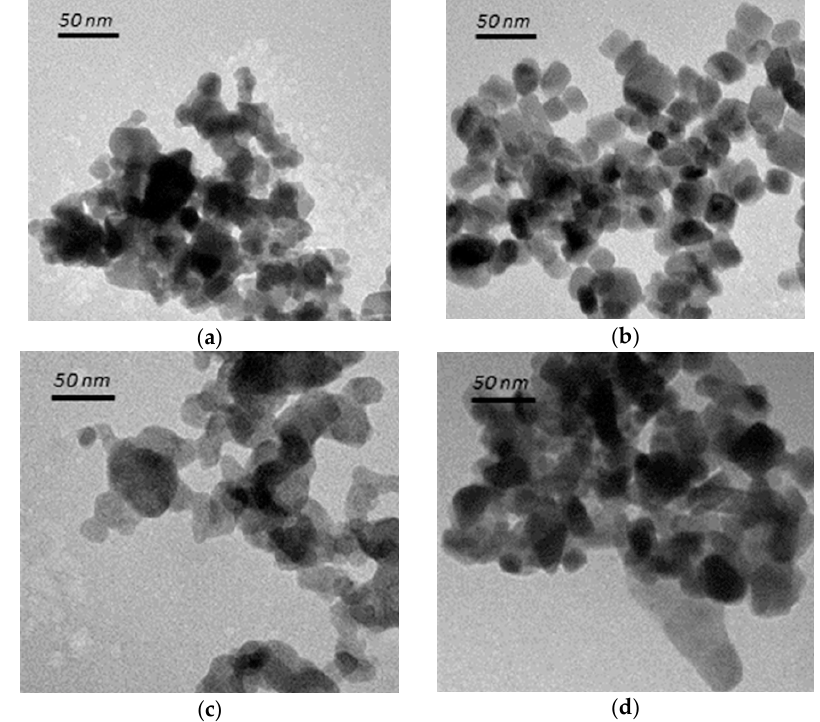
Figure 1. TEM images of ( a ) anatase spheroidal TiO 2 ; ( b ) anatase cubic TiO 2 ; ( c ) rutile spheroidal TiO 2 ; and ( d ) rutile cubic TiO 2 .